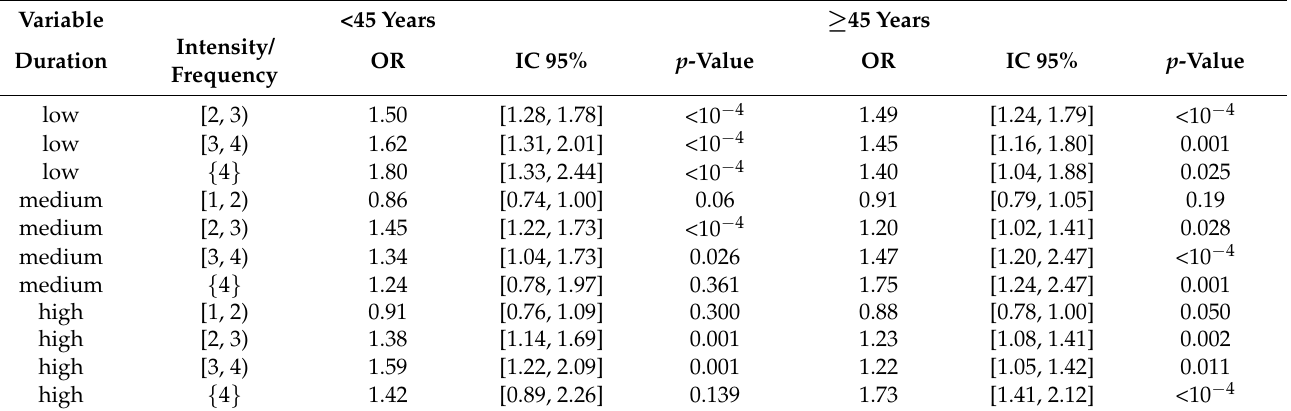
Table 7. Results of adjusted logistic regression of severe knee pain with kneeling, for <45 years old and 45 or more